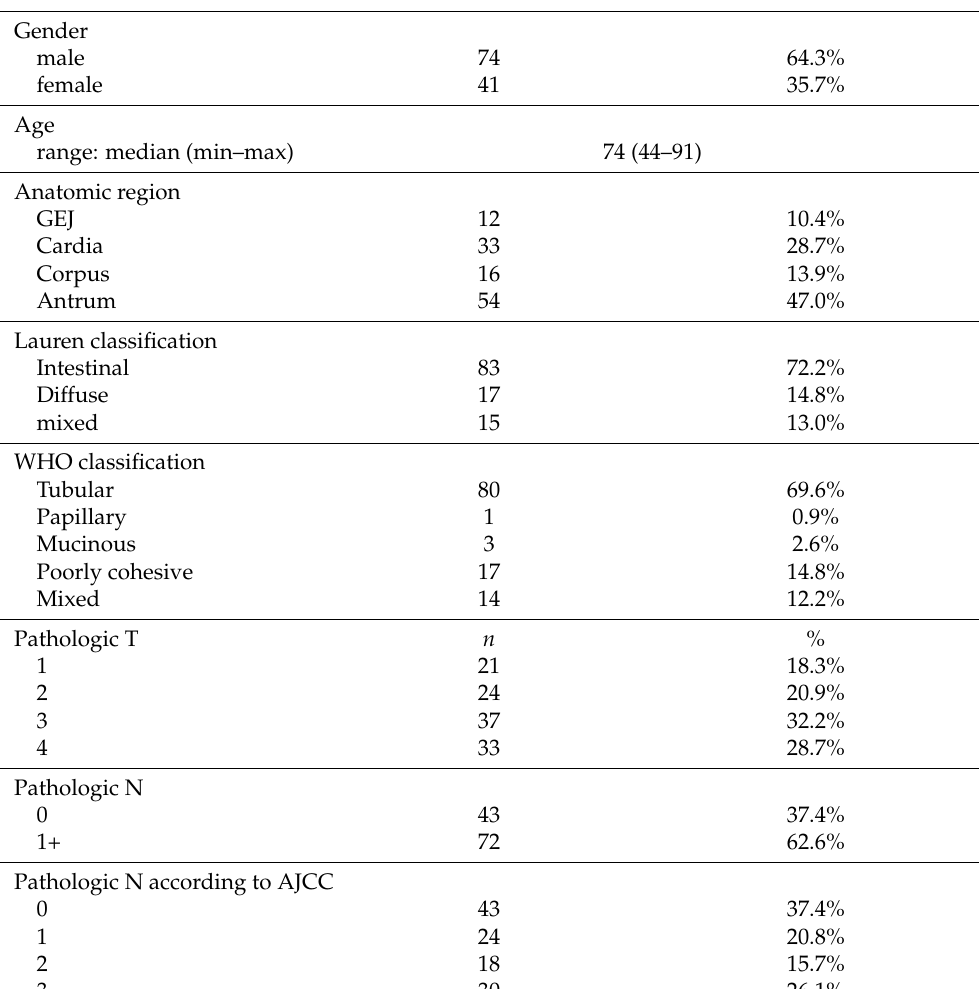
Table 1. Clinical and histological characteristics of 115 patients diagnosed with gastric adenocarcinoma.